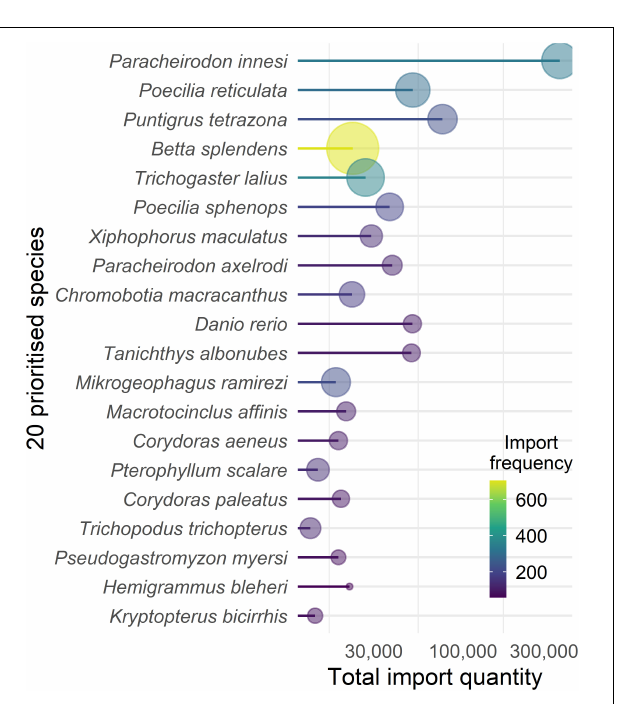
FIGURE 3 | The 20 prioritized aquatic ornamental species imported to New Zealand from 2015 to 2019 (inclusive) derived from, and ordered by, summed ranks of quantity and frequency. Total quantity ( x -axis) and frequency (color scale and bubble size) is shown for each